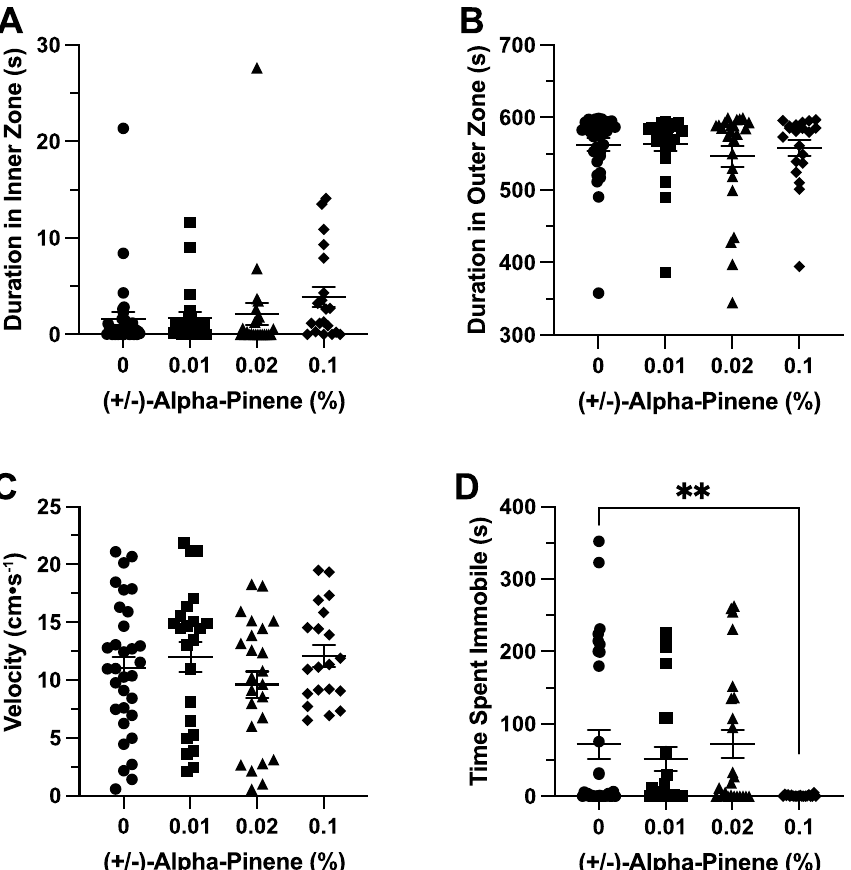
Figure 3. The effects of (+ /−)-alpha-pinene administration in the novel object approach test. Average duration of time fish spent in the ( A ) inner and ( B ) outer ‘thigmotaxis’ zone during the novel object approach test. Fish locomotion was quantified in the novel object approach test by measuring ( C ) swimming velocity and ( D ) time spent immobile. All data are presented as mean ± S.E.M. Significant differences between controls and (+ /−)-alpha-pinene treated groups are indicated by **( p <